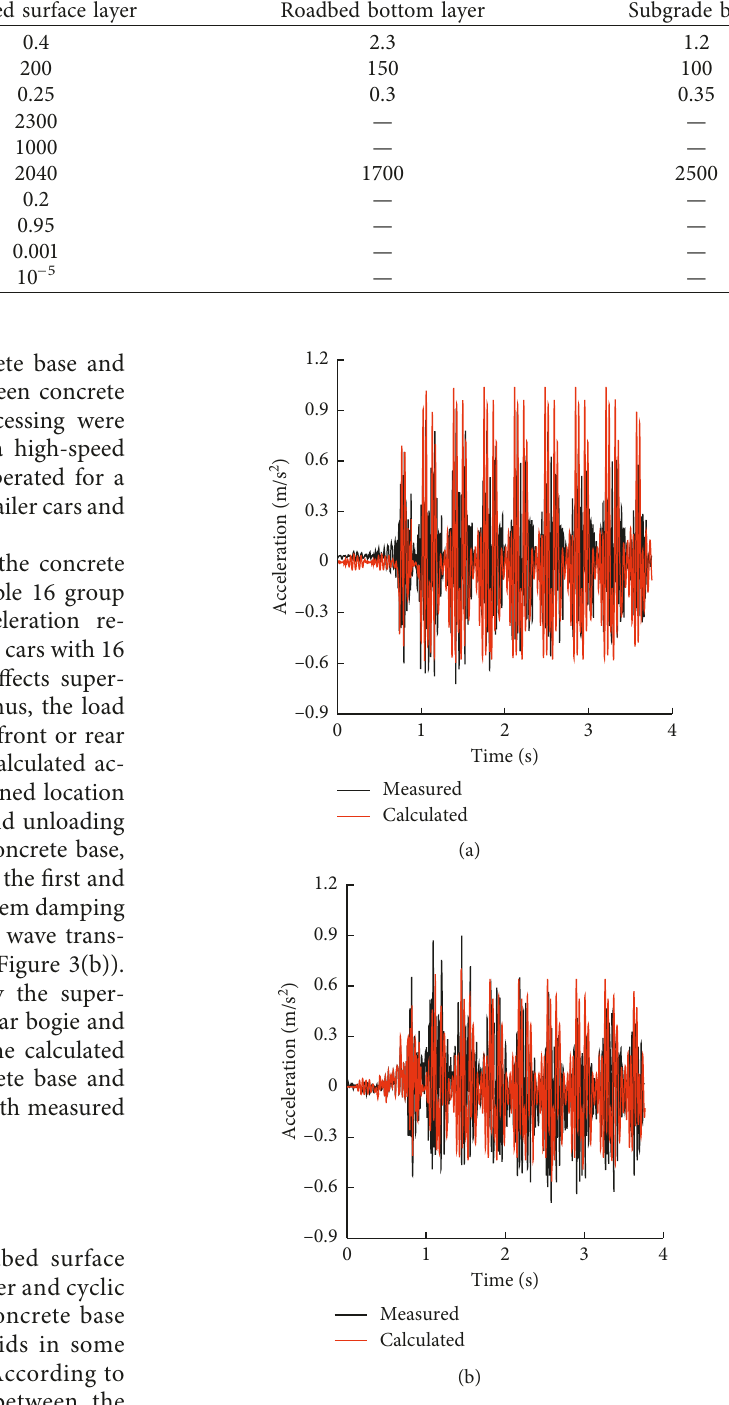
Figure 3: Calculated and measured acceleration-time curves: (a) the concrete base surface and (b) the roadbed